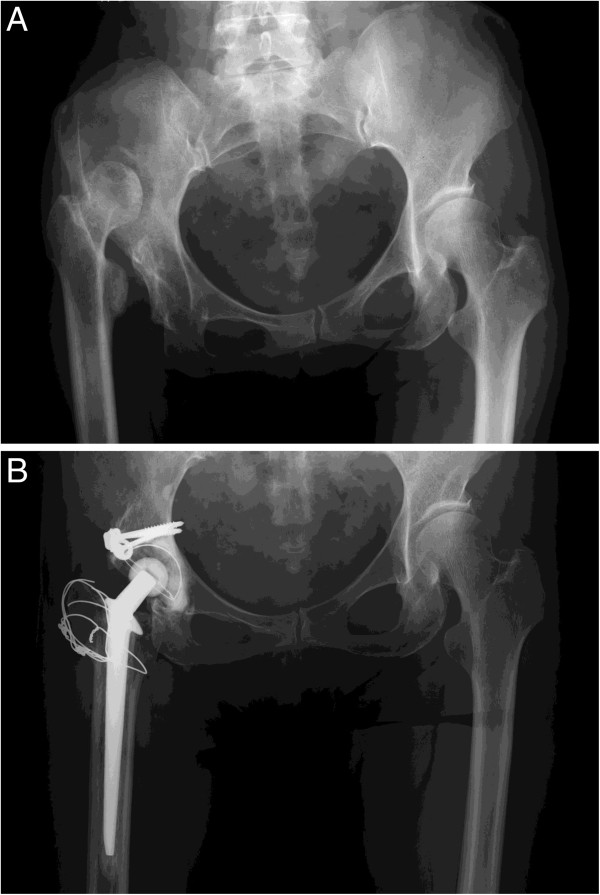
Radiographs of a representative case. A. An anteroposterior pelvic radiograph of a 57-year-old woman with Crowe IV complete dislocation of the right hip. B. A postoperative radiograph at 11 and a half years after a total hip arthroplasty with limb lengthening by 4.5 cm, showing no loosening or radiolucent line.